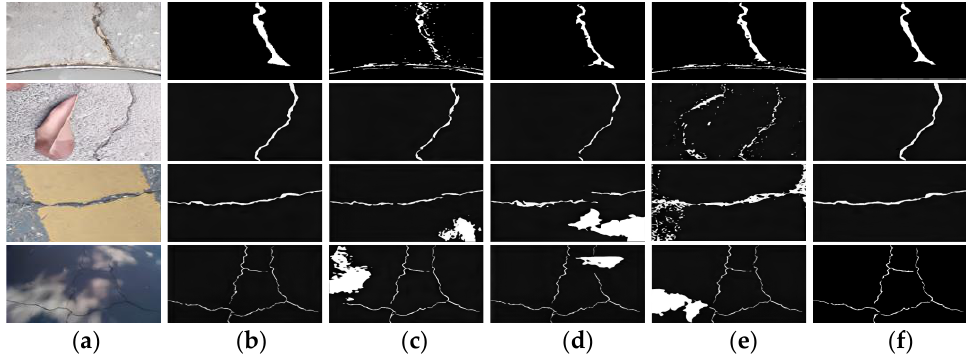
Figure 10. Visual comparison results of different algorithms in crack images with noise. ( a ) Road Image with Noise; ( b ) Ground Truth; ( c ) DeepCrack; ( d ) SegNet; ( e ) Fast-SCNN; ( f ) Ours.